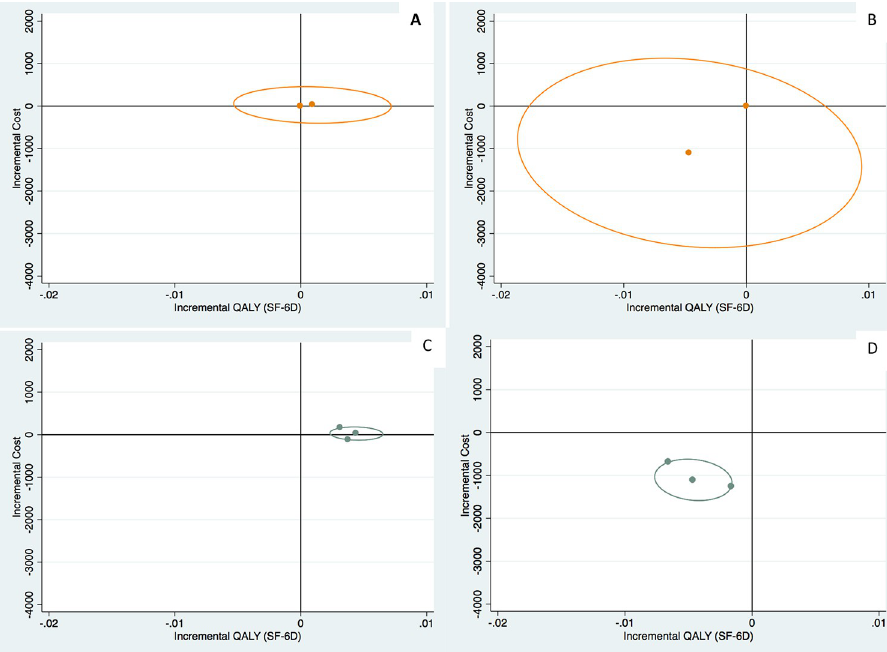
Fig 1. a: Cost-effectiveness plane: Complete case analysis for women, incremental cost-utility ratio based on QALYs estimated from the SF-6D. b: Cost-effectiveness plane: Complete case analysis for men, incremental cost-utility ratio based on QALYs estimated from the SF-6D. c: Cost-effectiveness plane: Imputed case analysis for women, incremental cost-utility ratio based on QALYs estimated from the SF-6D. d: Cost-effectiveness plane: Imputed case analysis for men, incremental cost-utility ratio based on QALYs estimated from the